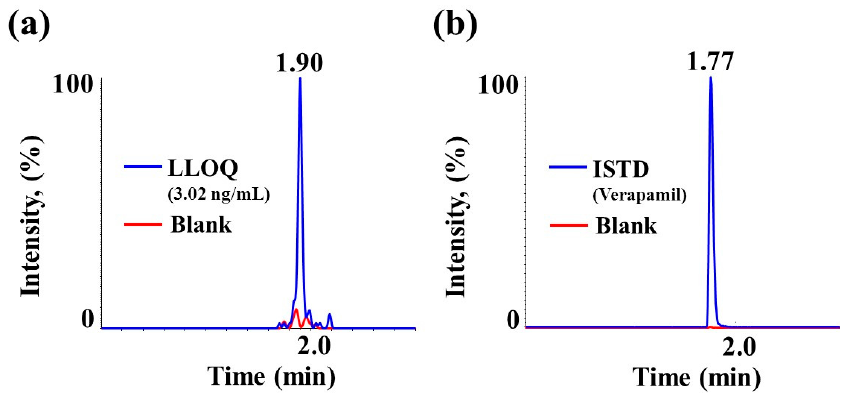
Figure 2. Representative chromatogram of ( a ) lower limits of quantification (LLOQ) (3.02 ng/mL) for SCH 58261 and ( b ) internal standard (ISTD) (verapamil) with blank matrix in rat plasma.